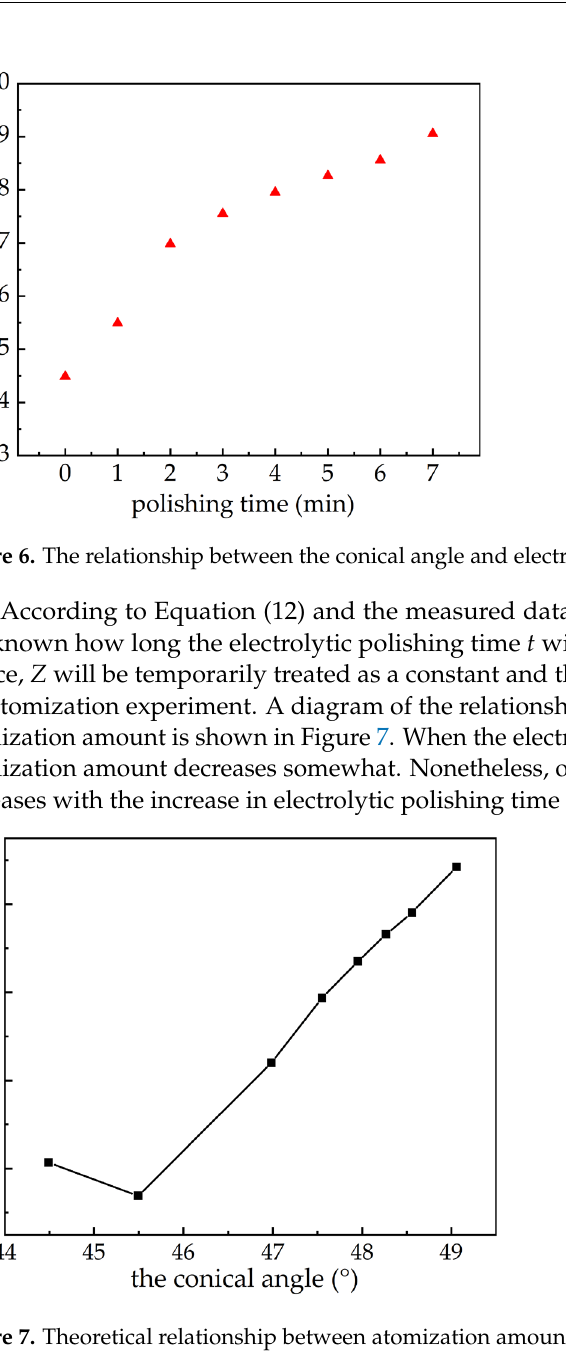
9 of 14 Figure 5. The relationship between electrolytic polishing time and metal sheet: ( a ) Relationship be- tween electrolytic polishing time and the diameter of micro-tapered holes; ( b ) Relationship between electrolytic polishing time and burr height. According to Equation (9) and the measured data in the experiment, the relation be-